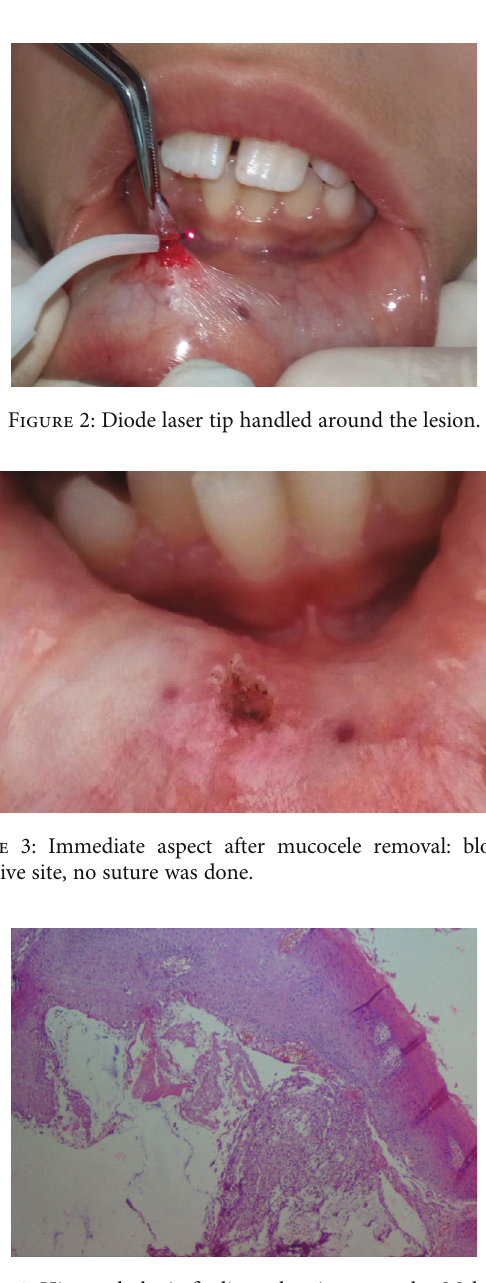
Figure 4: Histopathologic fi ndings showing a regular Malpighian epithelium and a subepithelial connective tissue occupied by a cystic cavity which was surrounded by a granulation tissue (hematoxylin and eosin, original magni fi cation, × 100).